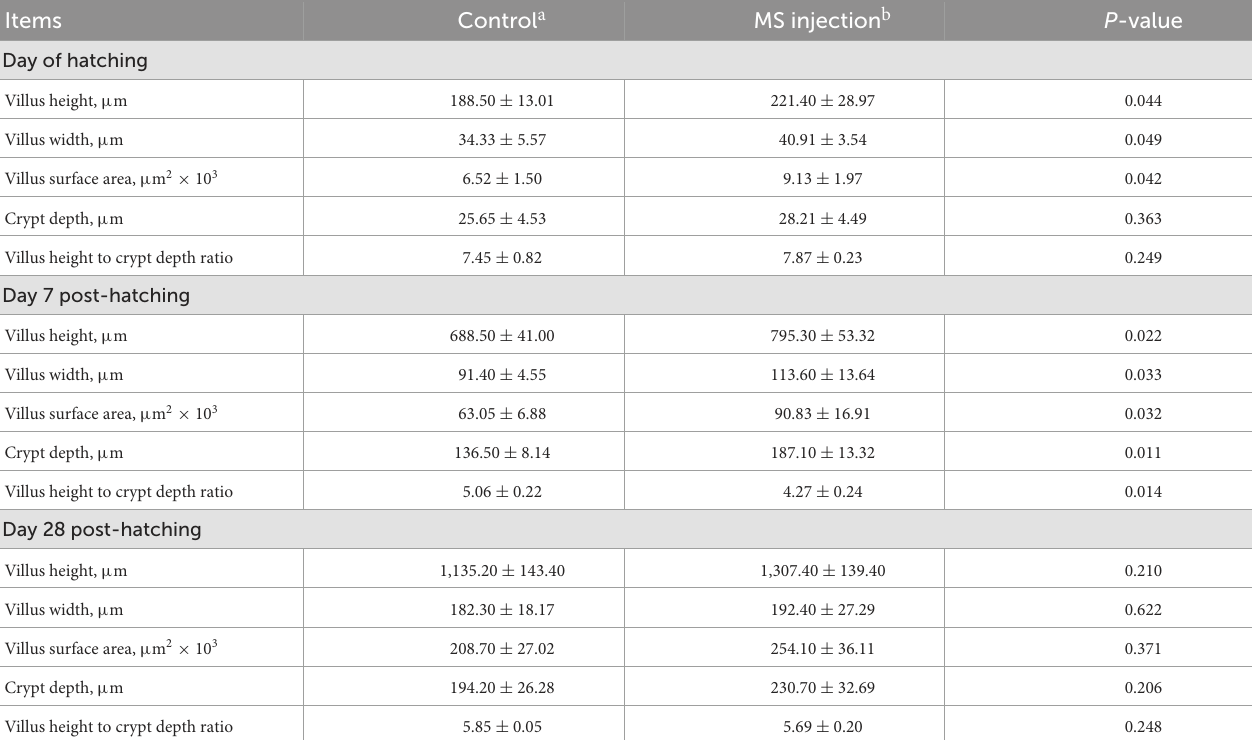
TABLE 4 Post-hatching jejunal morphology of goslings as affected by the in ovo injection of maltase and sucrose. Items